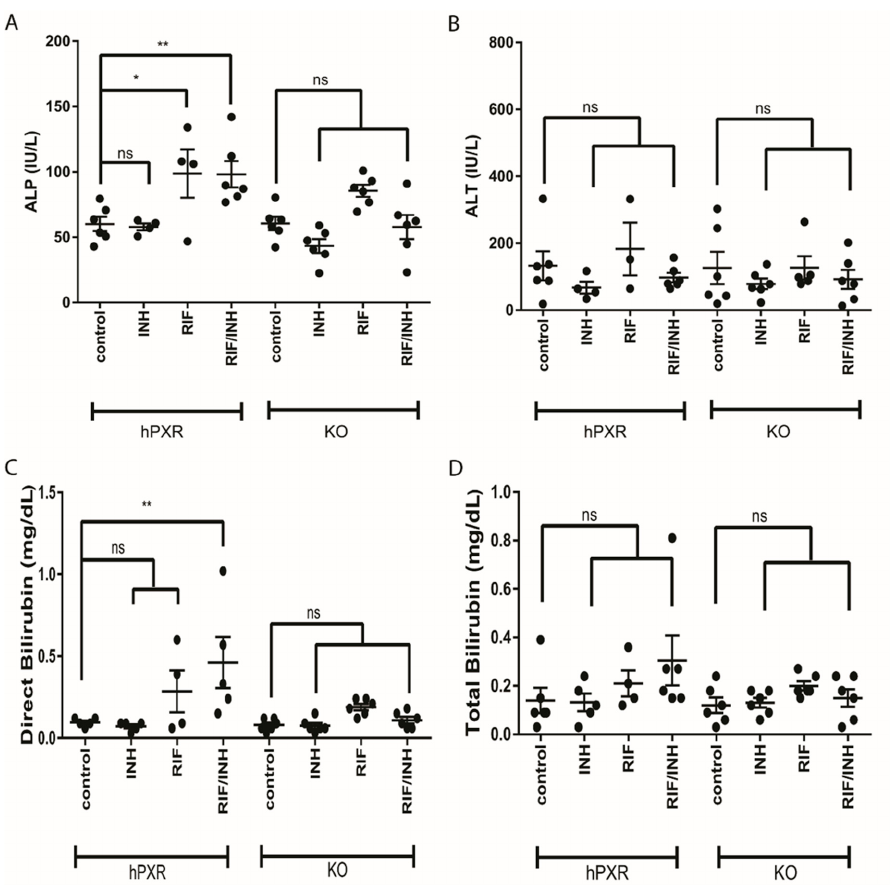
Figure 2. Liver function tests from human pregnane X receptor ( hPXR ) and mPxr –/– knockout (KO) mice treated with rifampicin (RIF) and isoniazid (INH). Sera were analyzed for markers of hepatotoxicity before liver collection. ( A ) Alkaline phosphatase (ALP), ( B ) alanine aminotransferate (ALT), ( C ) direct bilirubin, and ( D ) total bilirubin are shown. Data are expressed as the mean ± SEM. One-way ANOVA followed by Dunnett post hoc analysis was used to compare group means. ** p < 0.01, * p < 0.05, and ns (not